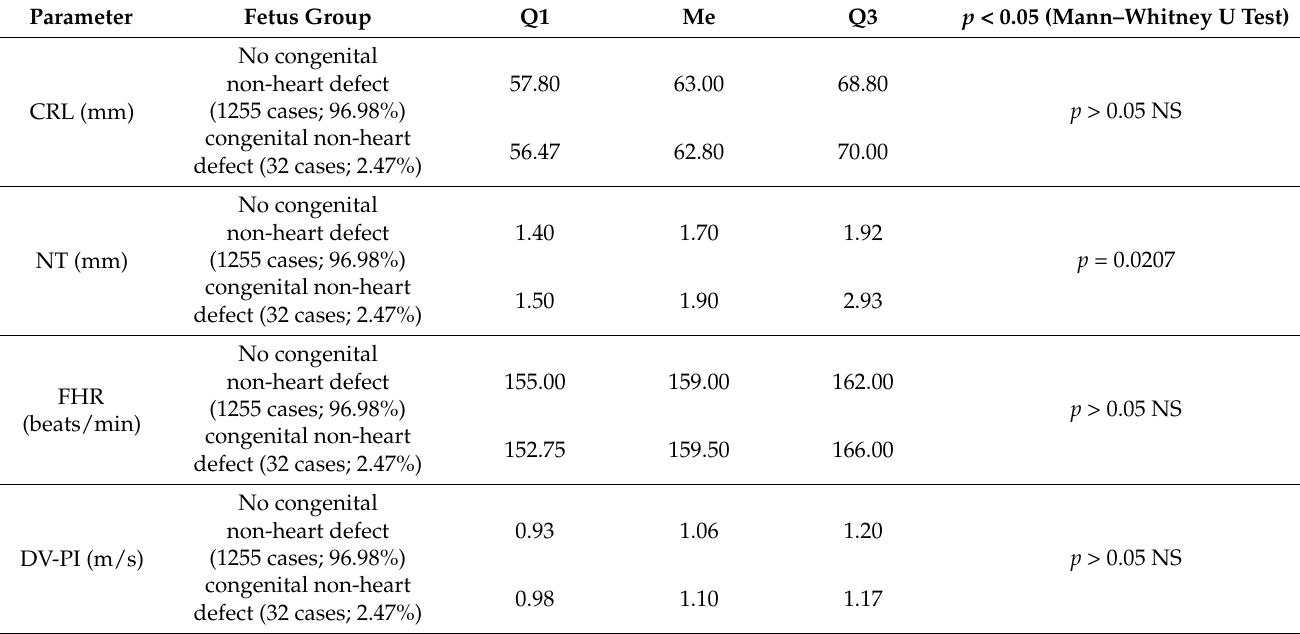
Table 5. Assessment of the parameters describing the growth and health of the fetus based on ultrasound examination in a group of women who became pregnant without the use of assisted reproduction